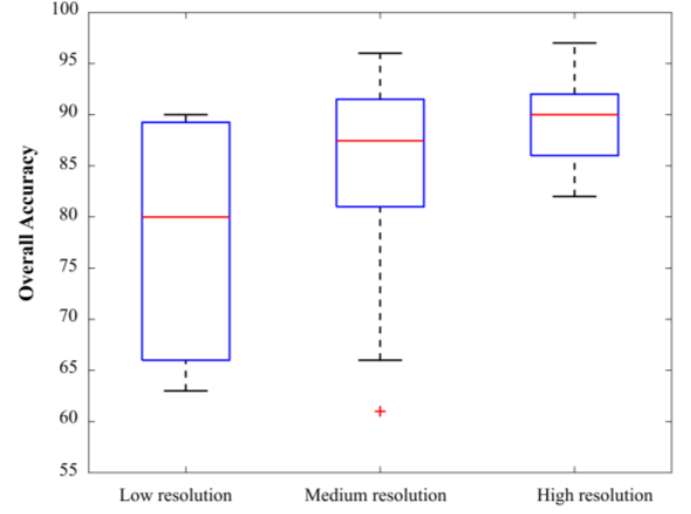
Figure 16. Correlation of overall accuracy and spatial resolution.